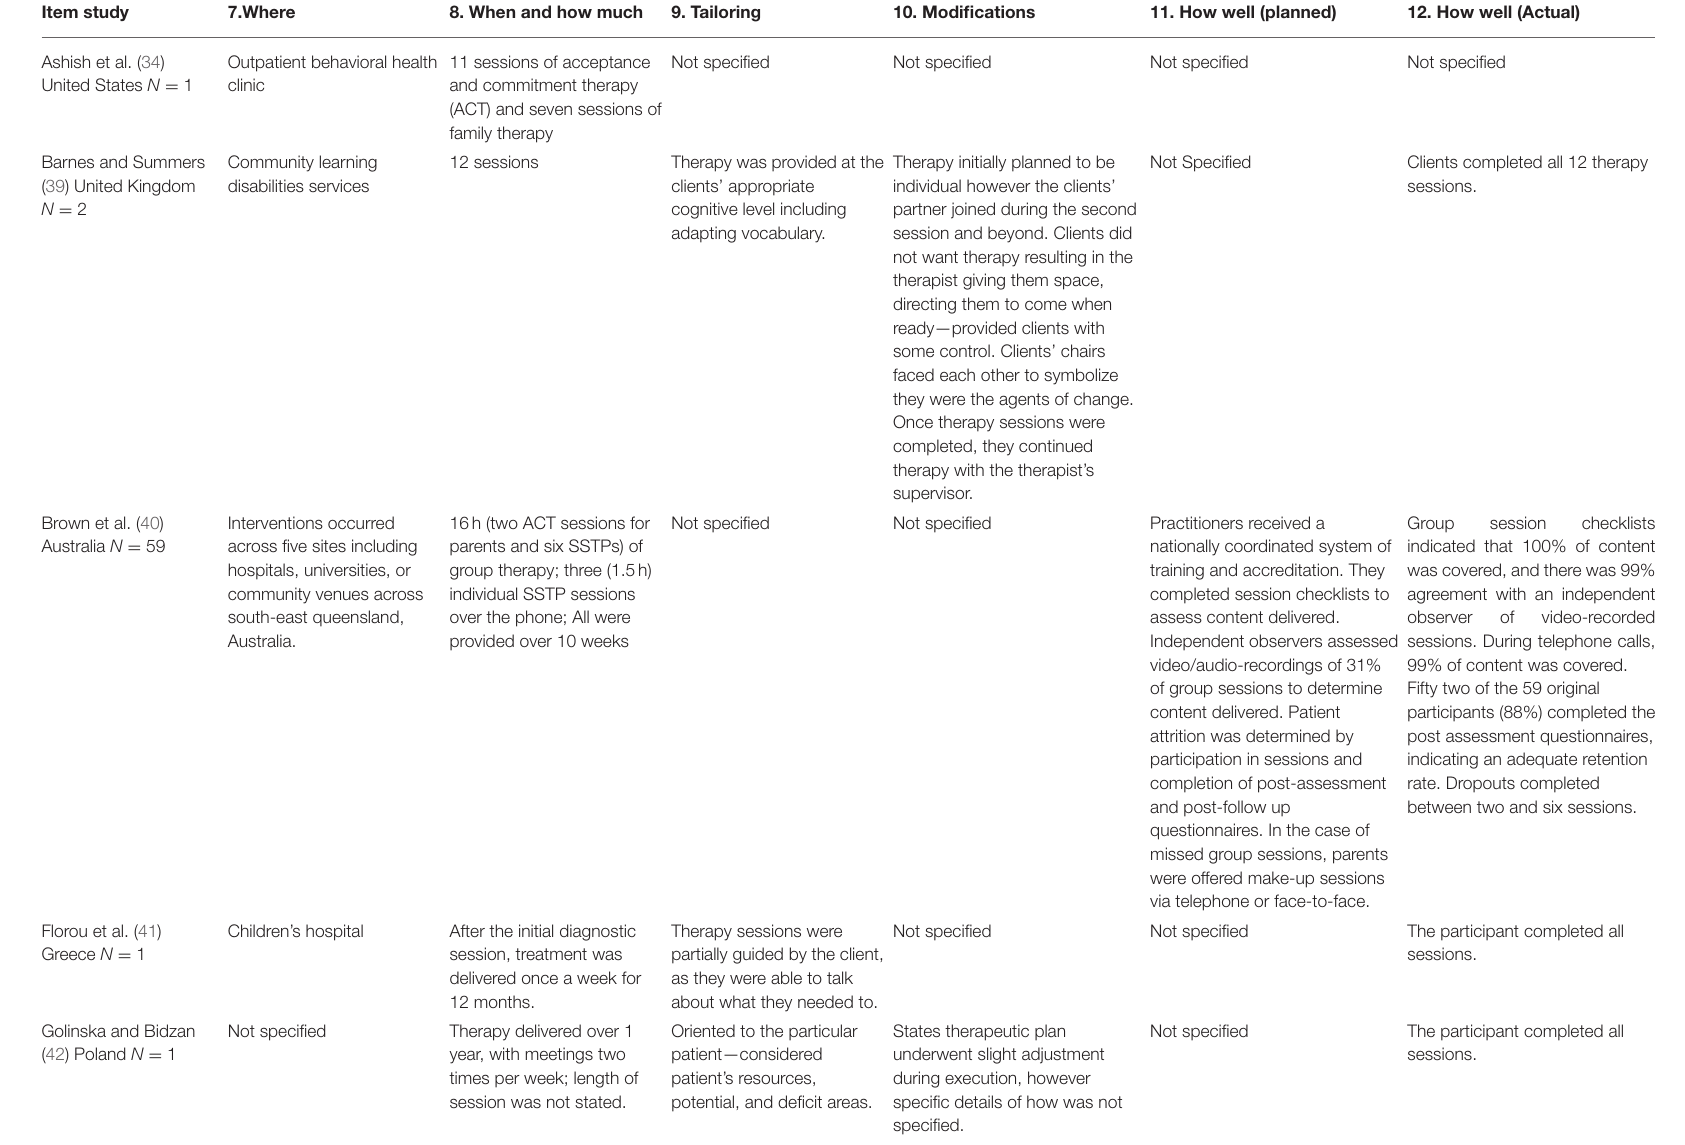
TABLE 2 | Summary of psychological interventions using the TIDieR framework items seven through